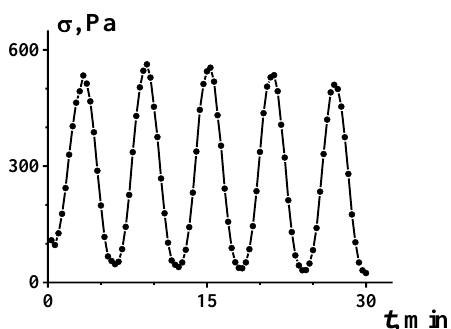
. γ = const . Stress oscillations const  =  . Stress oscil- const  = . Stress oscil-